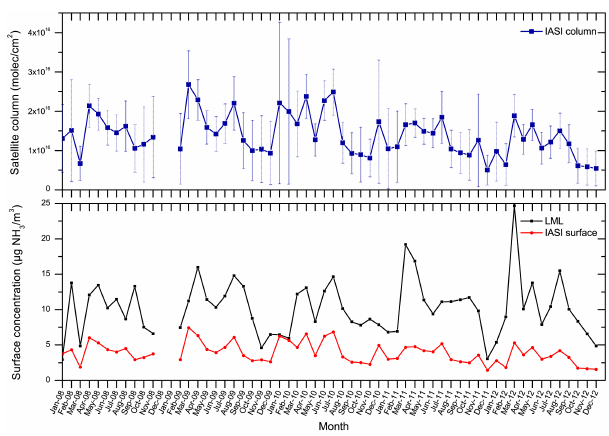
Figure 5. Monthly time series of NH 3 satellite columns (top, blue, moleccm − 2 ) and surface concentrations at the overpass time of the satellite (bottom) from all the sites of the Dutch LML network av- eraged (black, µgm − 3 ) and from IASI satellite observations (red, µgm − 3 ) (in the box 51.185–53.022 ◦ N and 4.01–7.106 ◦ E, cor- responding to the area covered by the Dutch network), covering 2008, 2009, 2010, 2011 and 2012. The associated error bars are based on the retrieval error for each monthly column, calculated following equations described in Van Damme et al. (2014a). Only monthly means associated with weighted relative retrieval errors be- low 100% are